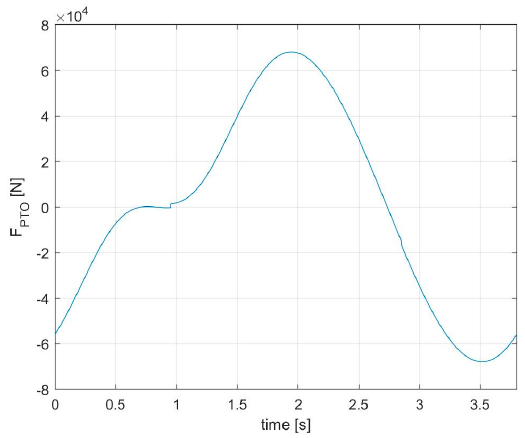
Figure 11. Axial force F PTO as a function of time.